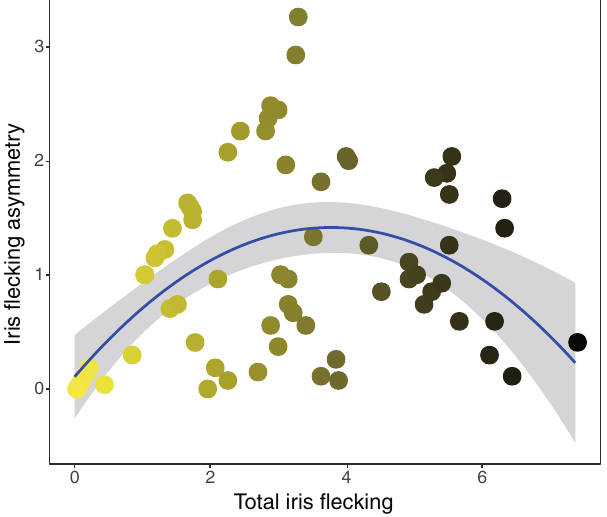
Figure 4. The variation of iris flecking asymmetry in relation to total iris flecking, and its quadratic fitted line (blue line) with 95% confidence interval (dark grey area). The equation for the model is y = − 0.09x 2 + 0.69x + 0.11. Each dot represents each individual and the color was graded from yellow to black according to the total amount of iris flecking.